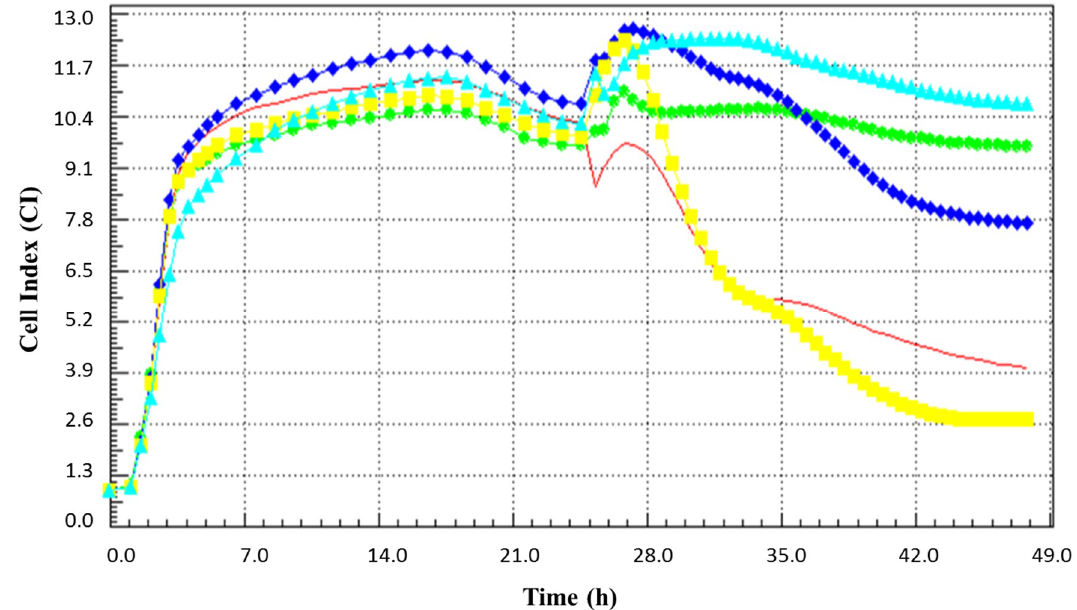
Figure 4. The real time cell monitoring profile of MA104 cells treated with the fraction of BCE based on the molecular weight prior to the rotavirus infection. The blue diamond line is the cell extract of B. longum BORI, the light blue triangle line is the low molecular weight ( < 10 kDa) fraction of cell extract, the yellow square line is the high molecular weight fraction ( ≥ 10 kDa) of cell extract, the red line represents infected cells, and green circle line represents non-infected cells.